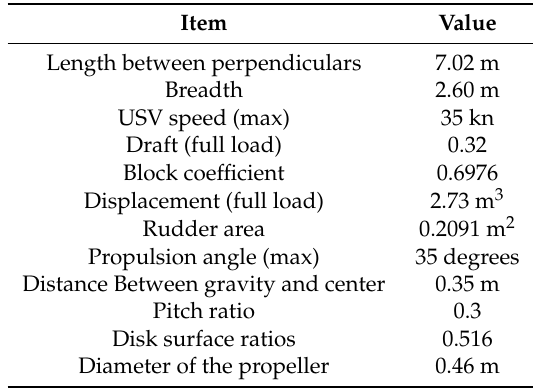
Table 1. Specific Parameters of the Lanxin Unmanned Surface Vehicle (USV).